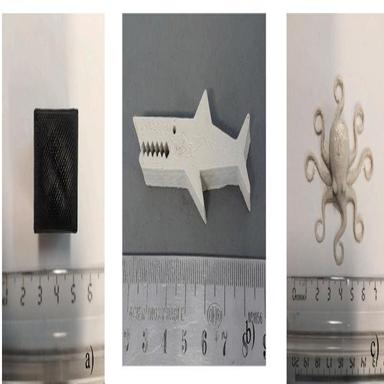
Examples of printed specimens with WEEE filaments: a) W1 cube, b) W7 stylized shark, c) W5 octopus.